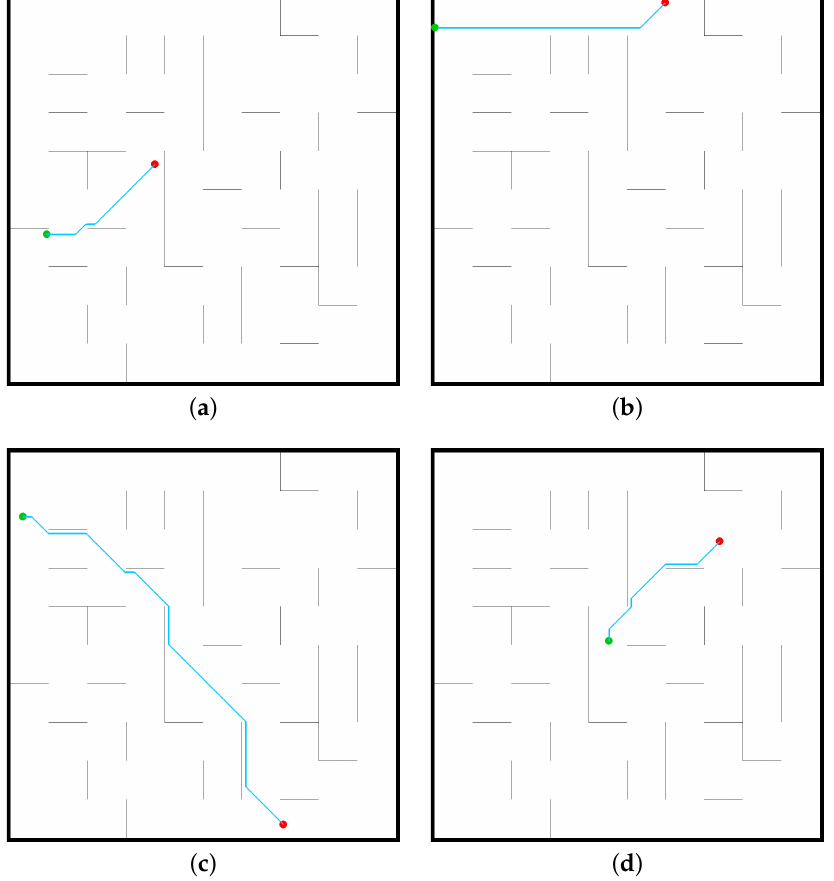
Figure 9. Successful cases using the APF algorithm to solve the mobile robot navigation task through analysis in RoNAP: ( a ) APF_case1, ( b ) APF_case2, ( c ) APF_case3, ( d )